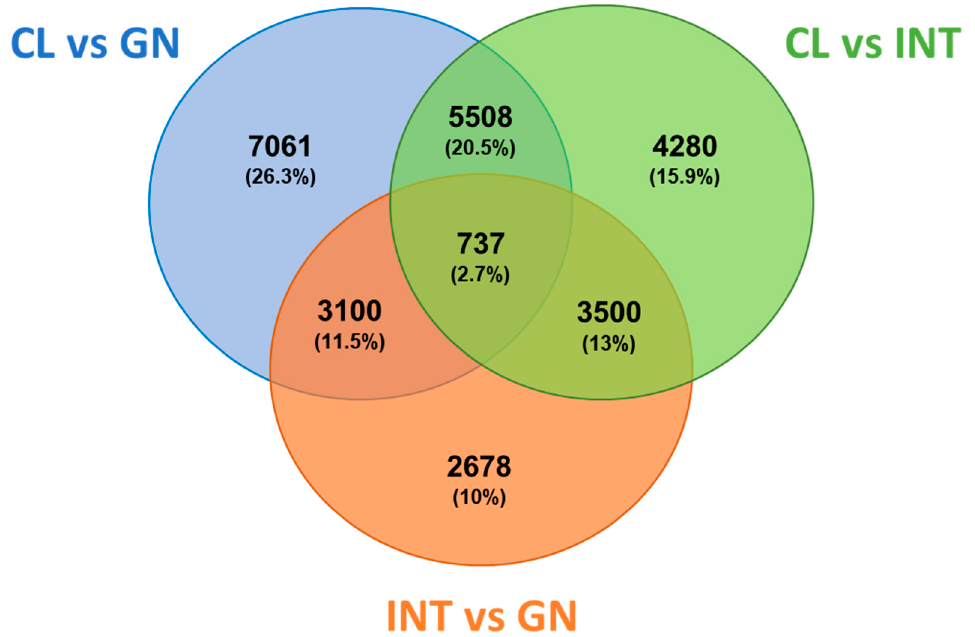
Figure 7. Differentially expressed transcripts between gonads, intestines, and coelomocytes of the edible sea urchin. Venn diagram of the total differentially expressed transcripts in L. albus . Each color indicates the comparison between tissue and the numbers of genes that were differentially expressed. Parameters: fold change (absolute values > 4.0) and FDR corrected p value ( p < 0.001). Abbreviations: CL: coelomocyte, INT: intestine, GN: gonad.